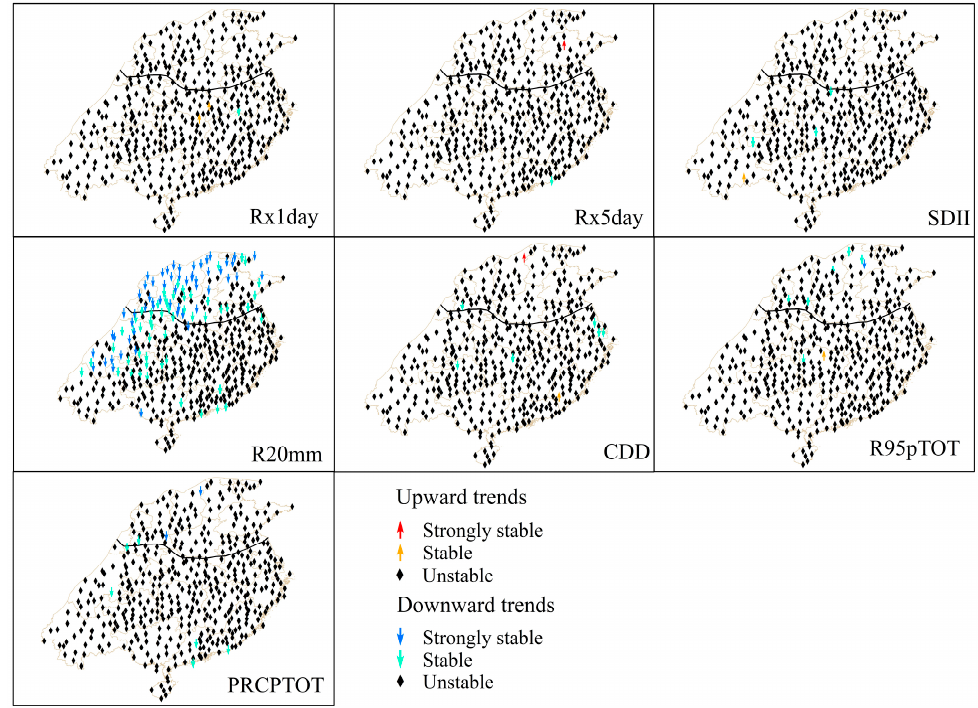
Figure 8. Stabilities of the statistically significant trends at each meteorological station for extreme precipitation indices during the growth period of October 1961 to May 2016